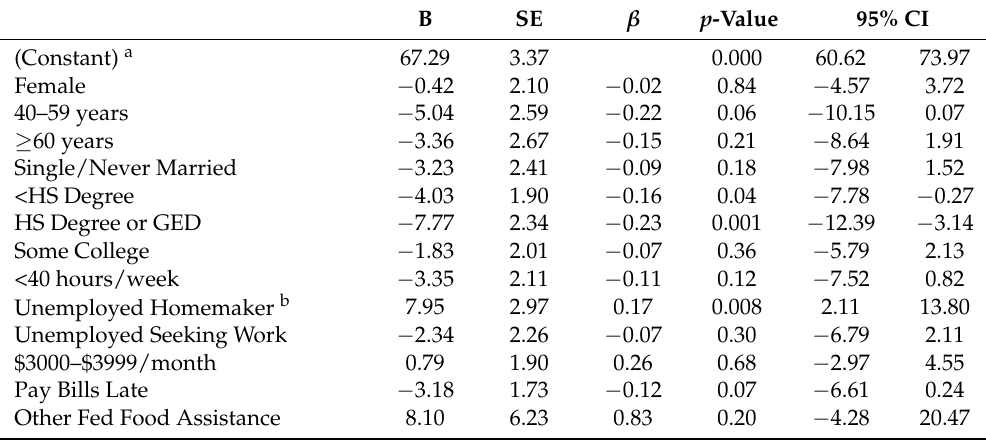
Table 4. Socio-Demographic and Disease-Related Characteristics Predictive of Diet